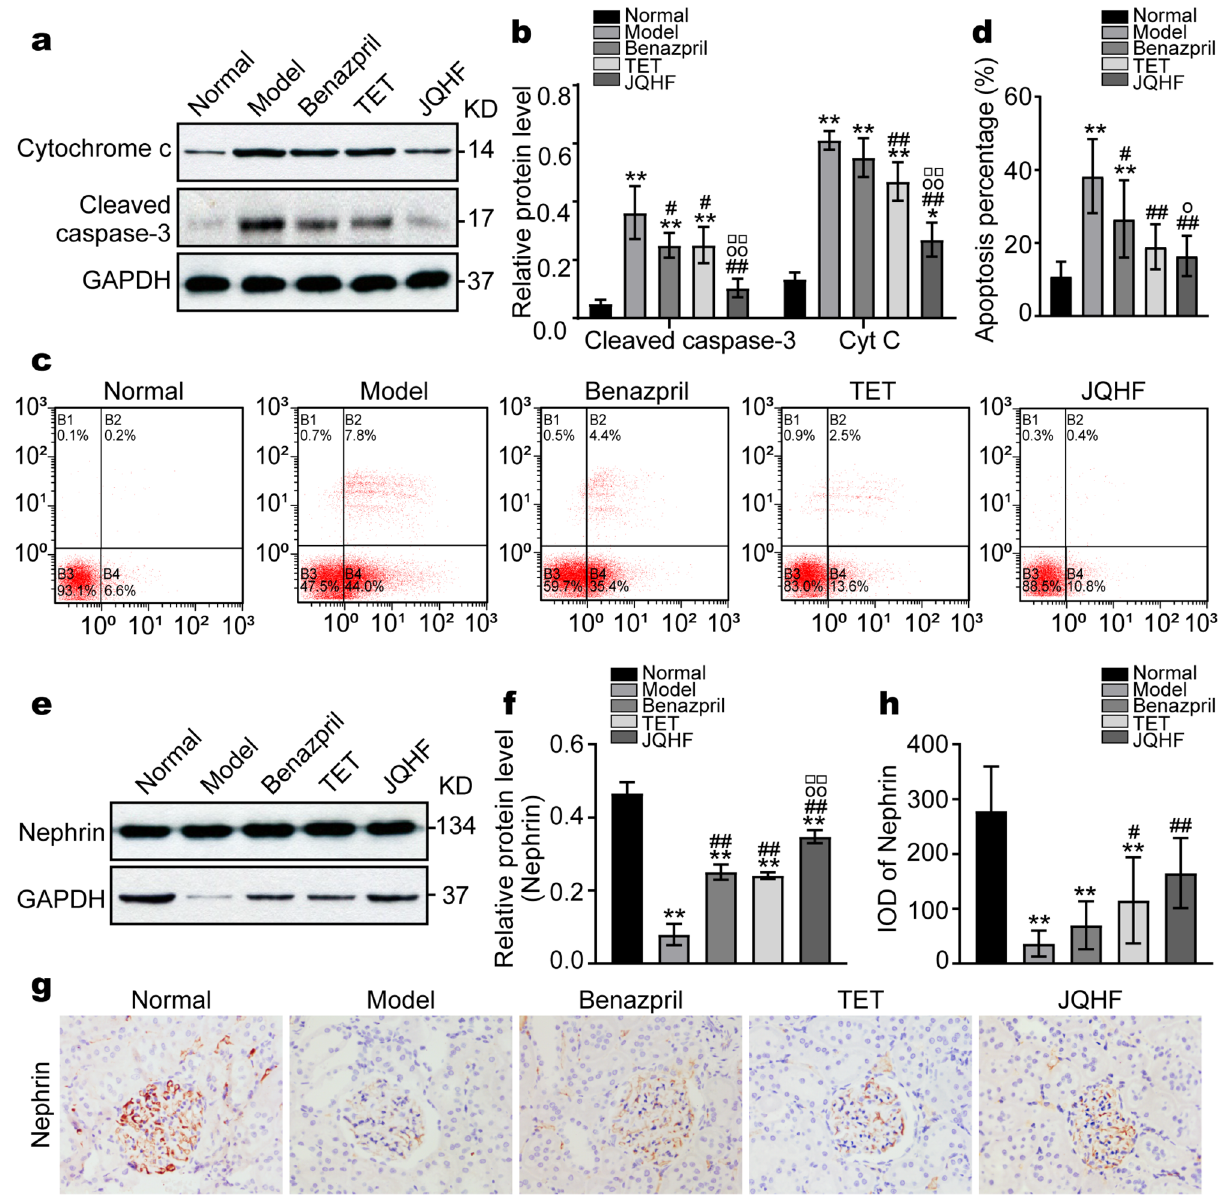
Figure. 4. JQHF reduce the apoptosis in the kidneys of PHN rats. ( a , e ) Western blot analysis of the expression of Cyt c, Cleaved caspase-3 and Nephrin protein in each group. Full-length blots and all replicates performed are presented in Supplementary Figs. 2, 3. ( b , f ) Quantitative analysis of the expression of Cyt c, Cleaved caspase-3 and Nephrin protein. ( c ) Determination of apoptosis rate by Annevin-V-FITC staining. ( d ) Quantifcation of the apoptosis rate in each group. ( g ) Immunohistochemistry staining of Nephrin protein (original magnifcation ×400). ( h ) Analysis of IOD of Nephrin. Data were analysed by one-way ANOVA followed by post hoc LSD test ( b , f , h ) and presented as the mean ± SD (n = 6). Data were analysed by Kruskal Wallis H test ( d ) (n = 6). *P < 0.05 vs. Normal group, **P < 0.01 vs. Normal group, # P < 0.05 vs. Model group, ## P < 0.01 vs. Model group, ○ P < 0.05 vs. Benazepril group, ○○ P < 0.01 vs. Benazepril group and □□ P < 0.01 vs. TET